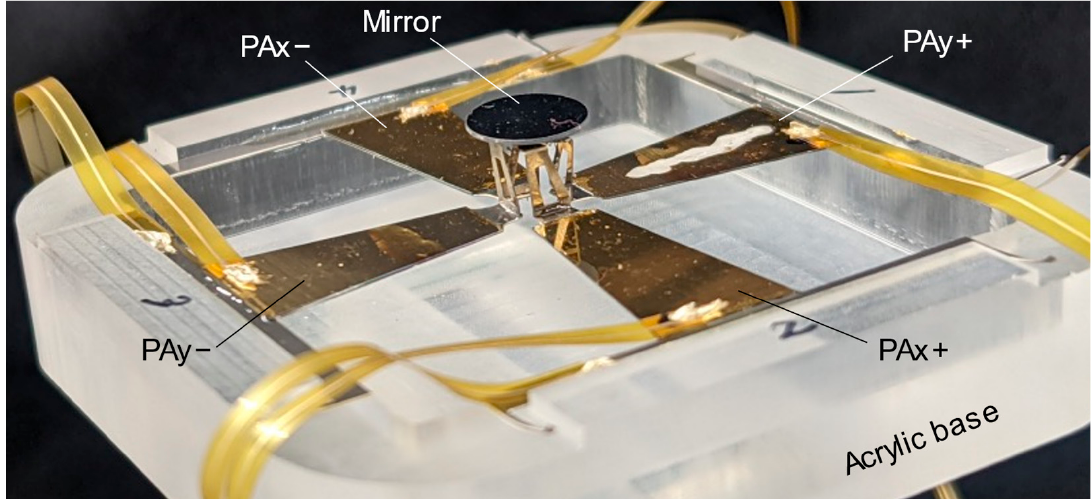
Figure 7. Photograph of the fabricated scanner.